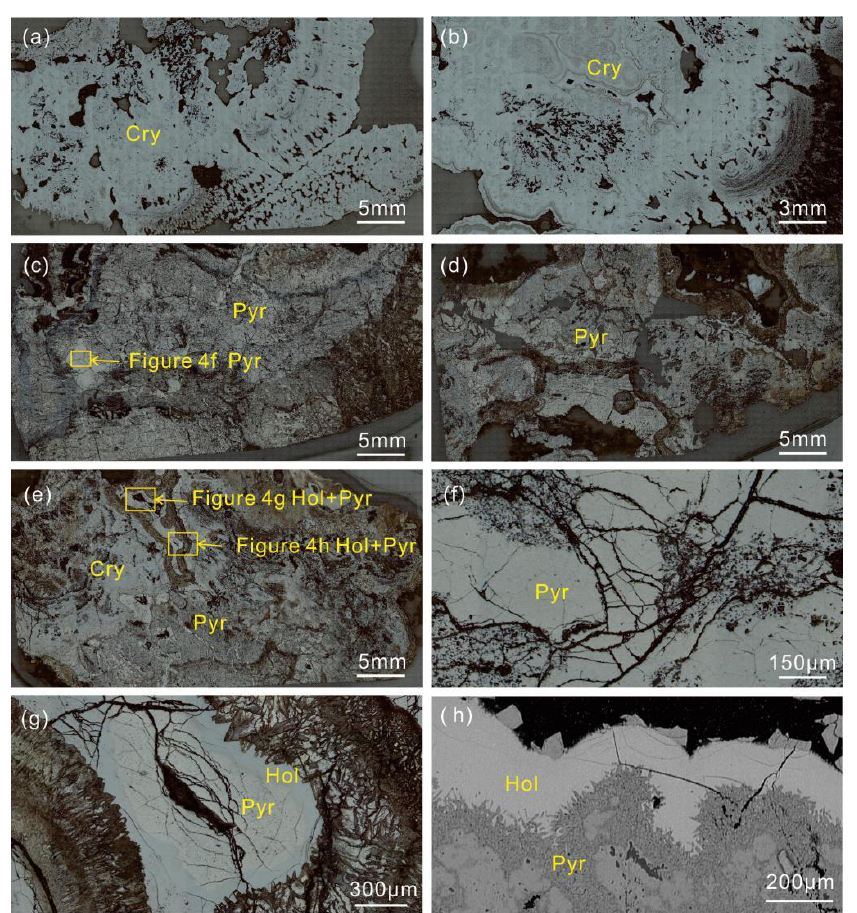
Figure 4. Representative thin section photomicrographs and back-scattered electron images of the Mn-oxide ore in the Xialei deposit. ( a , b ) Cryptomelane showing light whitish green to off-white reflection color, annulus texture; ( c – f ) Pyrolusite showing an earthy-yellow, yellow-white to cream- yellow reflection color and a massive texture; ( e ) Mineral assemblage of pyrolusite, cryptomelane, and hollandite; ( g , h ) Annule-type texture of pyrolusite and hollandite, with hollandite colloidal structure. Microphotographs ( a – g ) are reflective light images, the image in ( h ) is a back-scattered electron image. Cry—Cryptomelane; Pyr—Pyrolusite;